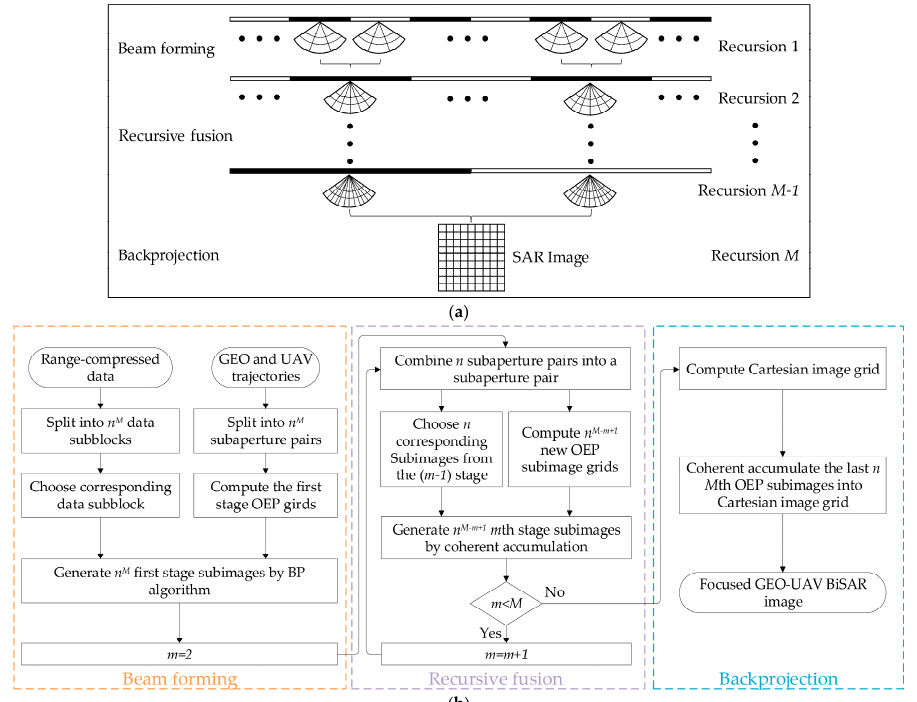
Figure 7. Procedures of the proposed bistatic FFBP algorithm. ( a ) Diagram; ( b ) Flow chart. Provided that the number of the subaperture pairs of the GEO satellites and UAV combined at each stage of the interpolation fusion is 𝑛 , the total number of the subaper- ture pairs is 𝑛 (cid:3014)(cid:2879)(cid:3040)(cid:2878)(cid:2869) after 𝑚 recursive fusion stages. In the beamforming stage, using the 𝑘 th fi rst-stage subimage as an example, each pair of the subapertures of the GEO satellite and UAV with the corresponding range-compressed echo data generates a subimage with the lowest resolution using the subaperture imaging algorithm outlined in Section 3.1. The location of the origin of the OEP system is determined by (4) based on the center positions of the subaperture of the GEO satellite and UAV and the center point of the imaging area. Then, the subimage grid is determined according to the Nyquist sampling requirements presented in (12) and (25). Finally, the subimages in the OEP system are obtained by the BP algorithm according to (11), which is given by 𝐼 (cid:3038)(cid:2869) (𝜌 (cid:3038)(cid:2869) ,𝜃 (cid:3038)(cid:2869) ;𝜂 (cid:3038)(cid:3030)(cid:2869) ) = (cid:3533)𝑠′ (cid:3045)(cid:3030) (cid:3435)𝑅 (cid:3003) (cid:3435)𝜌 (cid:3038)(cid:2869) ,𝜃 (cid:3038)(cid:2869) ;𝜂 (cid:3036)(cid:2869),(cid:3038) (cid:3439)/𝑐 (cid:2868) ,𝜂 (cid:3036)(cid:2869),(cid:3038) (cid:3439)exp(cid:3435)𝑗2𝜋𝑓 (cid:3030) 𝑅 (cid:3003) (cid:3435)𝜌,𝜃;𝜂 (cid:3036)(cid:2869),(cid:3038) (cid:3439)/𝑐 (cid:2868) (cid:3439) (cid:3039) (cid:3036)(cid:2880)(cid:2869) (31) where 𝜌 (cid:3038)(cid:2869) and 𝜃 (cid:3038)(cid:2869) represent the two-way slant range and angular coordinates of the 𝑘 th subimage in the fi rst stage, respectively, while 𝜂 (cid:3038)(cid:3030)(cid:2869) refers to the subaperture center mo- ment corresponding to that subimage. 𝜂 (cid:3036)(cid:2869),(cid:3038) represents the slow time of the sampling point within the subaperture time.